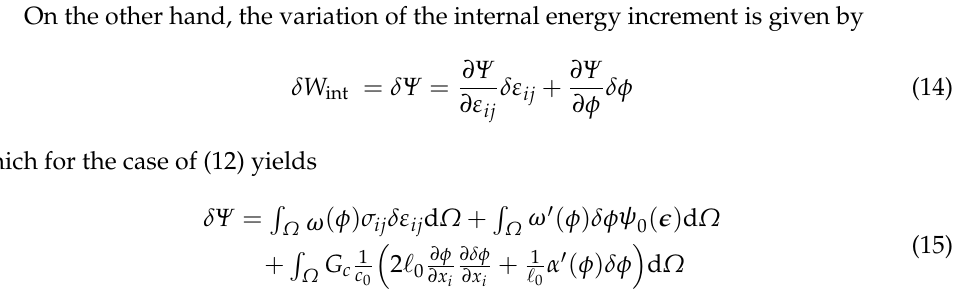
∂𝛺 (cid:3048) and tractions 𝒕 ∗ for ∂𝛺 (cid:3047) , respectively. The outward unit normal vector of external boundary